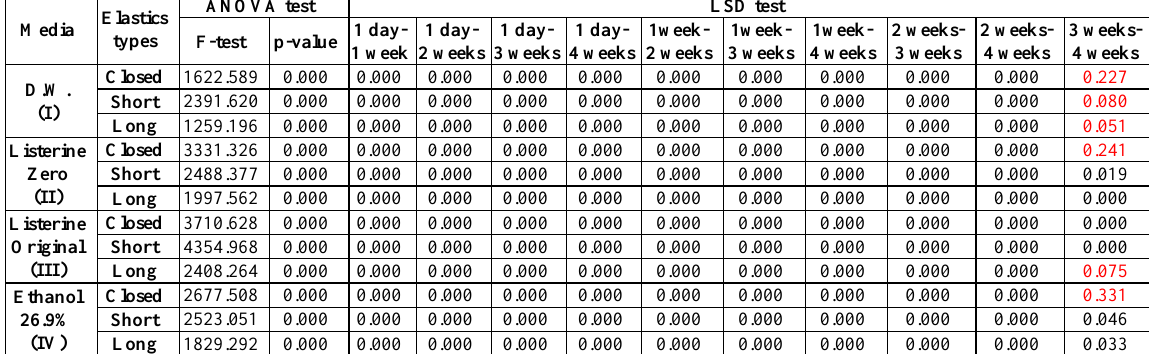
Table 3: Effect of immersion time on force degradation of different types of elastomeric chains in different chemical testing